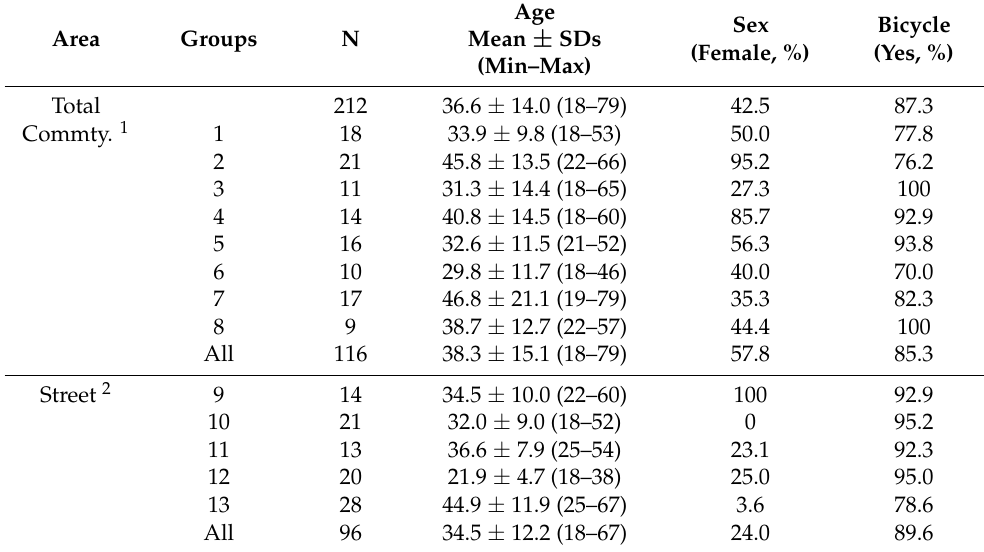
Table 2. Characteristics of community sense/street sense groups: age, sex,